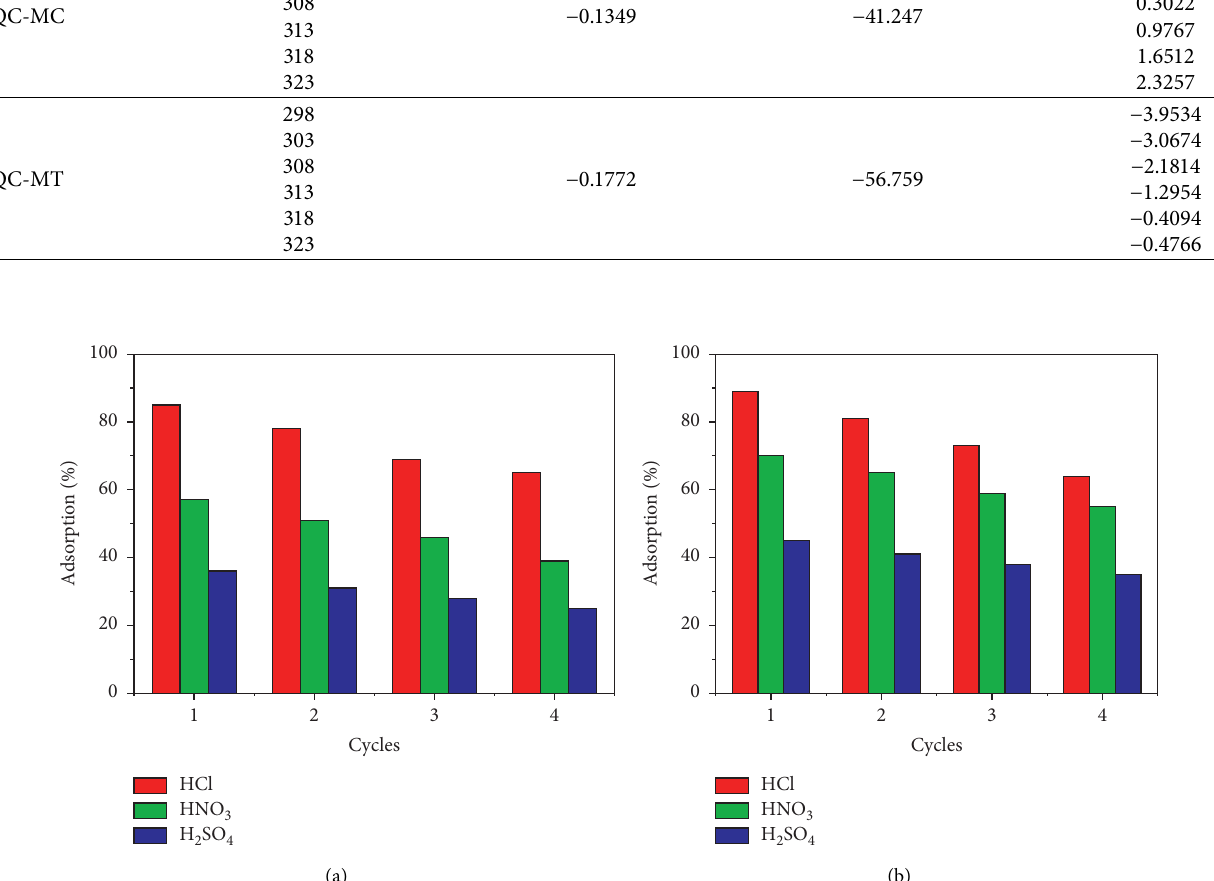
Figure 11: The regeneration of (a) QC-MC and (b) QC-MT ( V � 100mL, m � 1.5g, T � 25 ° C, and contact time � 30min for QC-MC and 45min for QC-MT).